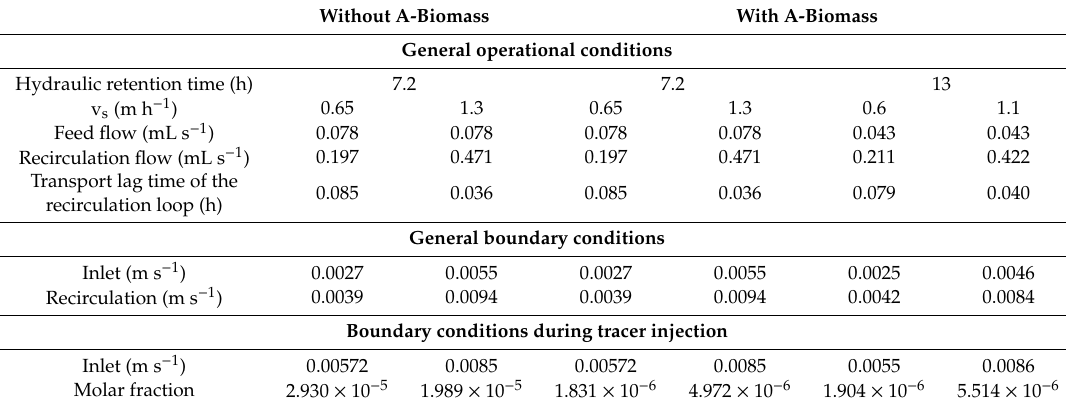
Table 1. Operating conditions of the tubular